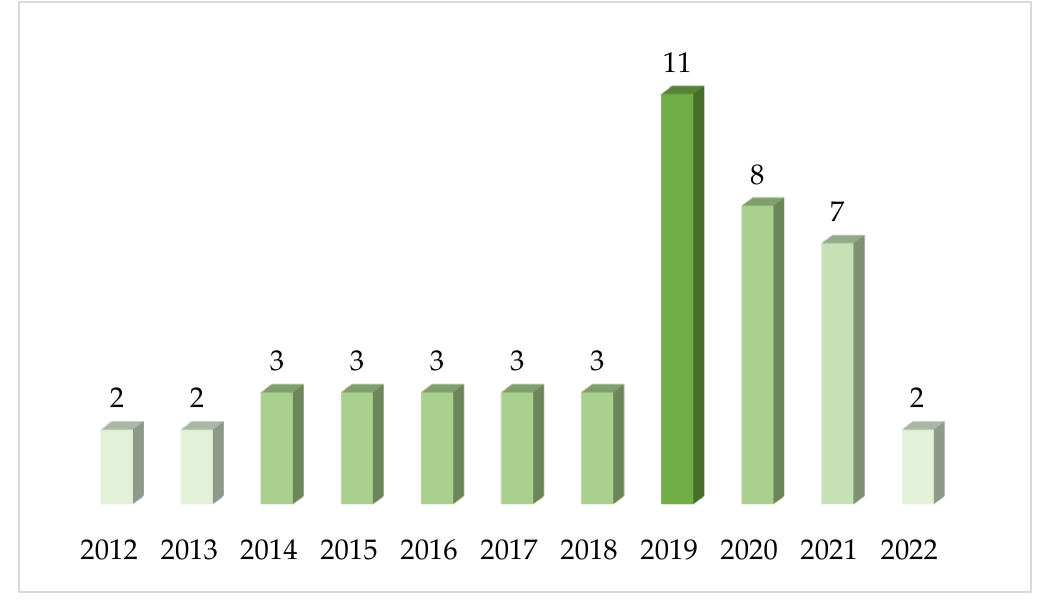
Figure 2. Percentage of ranked journals in the bibliographic data.